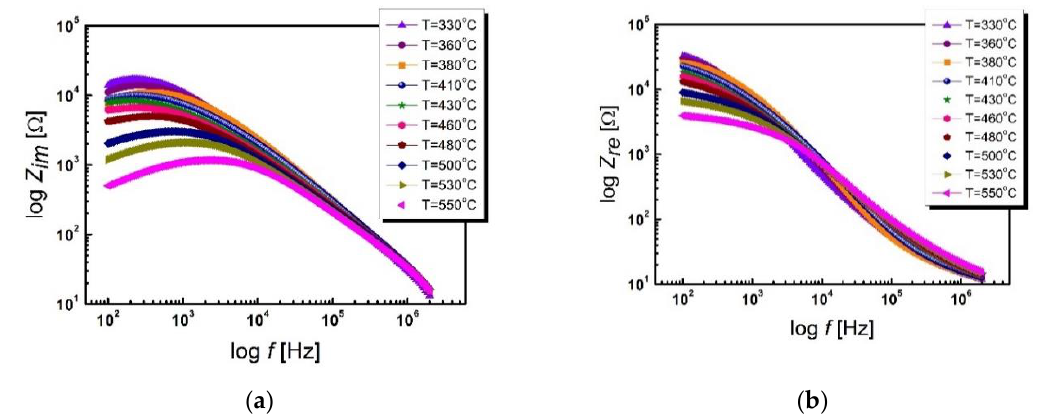
Figure 5. Frequency dependence of the impedance of the imaginary part, Z im , ( a ) and the real part, Z re , ( b ) on the frequency, f , at different temperatures of BLT4 ceramics.